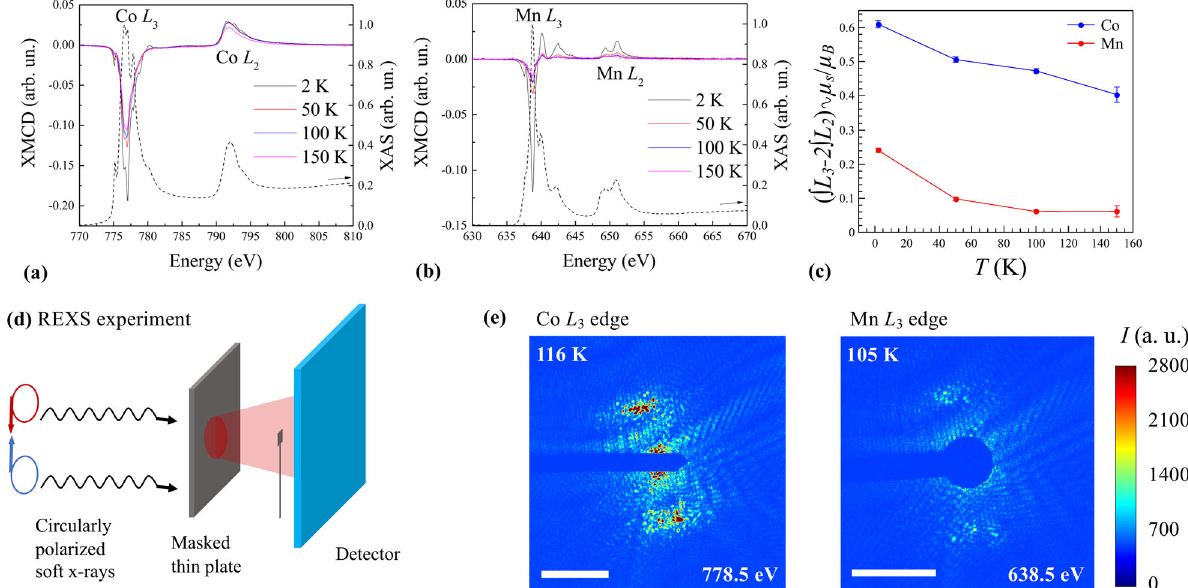
Fig. 3 X-ray spectroscopy and scattering from Co 7 Zn 7 Mn 6 . XAS and XMCD spectra of Co 7 Zn 7 Mn 6 measured near ( a ) Co and ( b ) Mn L 2,3 edges at H = 50 kOe. c Temperature dependence of XMCD signals ∫ L 3 − 2 ∫ L 2 of Co and Mn integrated across corresponding edges. Error bars indicate the statistical error. d Schematic geometry of the REXS experiment. e Zero- fi eld REXS patterns measured at Co ( E = 776.5 eV) (left panel) and Mn ( E = 638.5 eV) (right panel) edges at various temperatures. The white scale bar corresponds to reciprocal space distance of 0.01 Å − 1 . The central part of the scattering patterns is shadowed by the